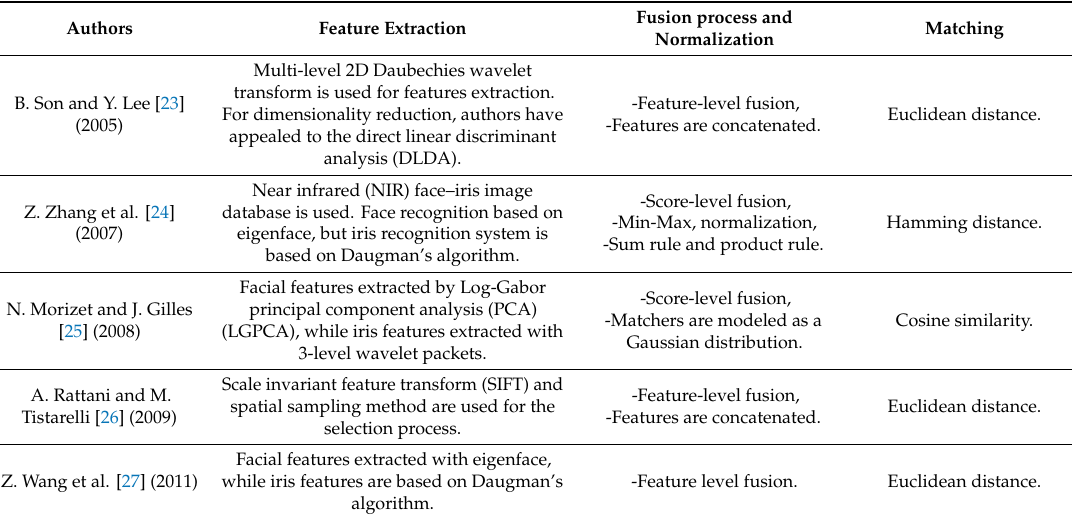
Table 1. Related works integrating both face and iris